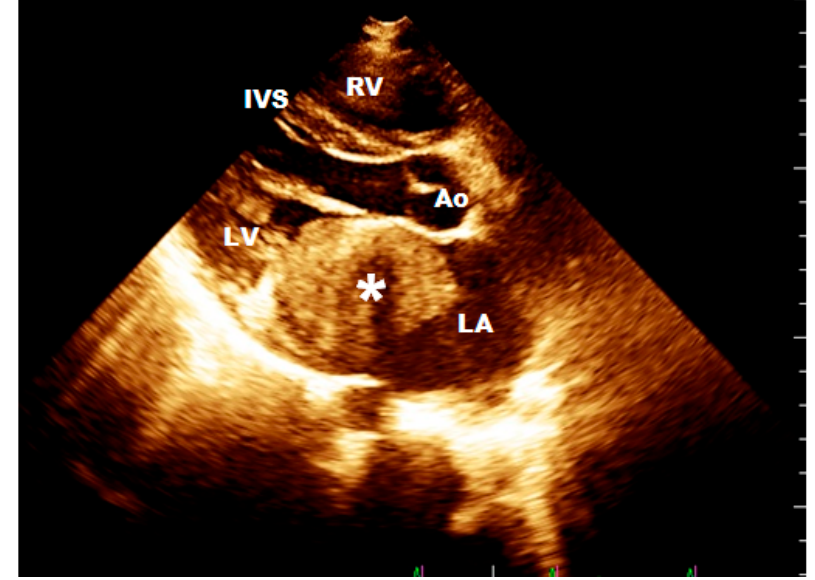
Figure 1. Two-dimensional echocardiography: parasternal long axis image obtained in a 16-year boy shows a huge hyperechoic mass (*) in the left atrium (LA) which was significantly hindering the flow of blood to the left ventricle through the mitral valve. RV—Right Ventricle; IVS—Interventricular Septum; LV— Left Ventricle; LA—Left Atrium; Ao—Aorta.